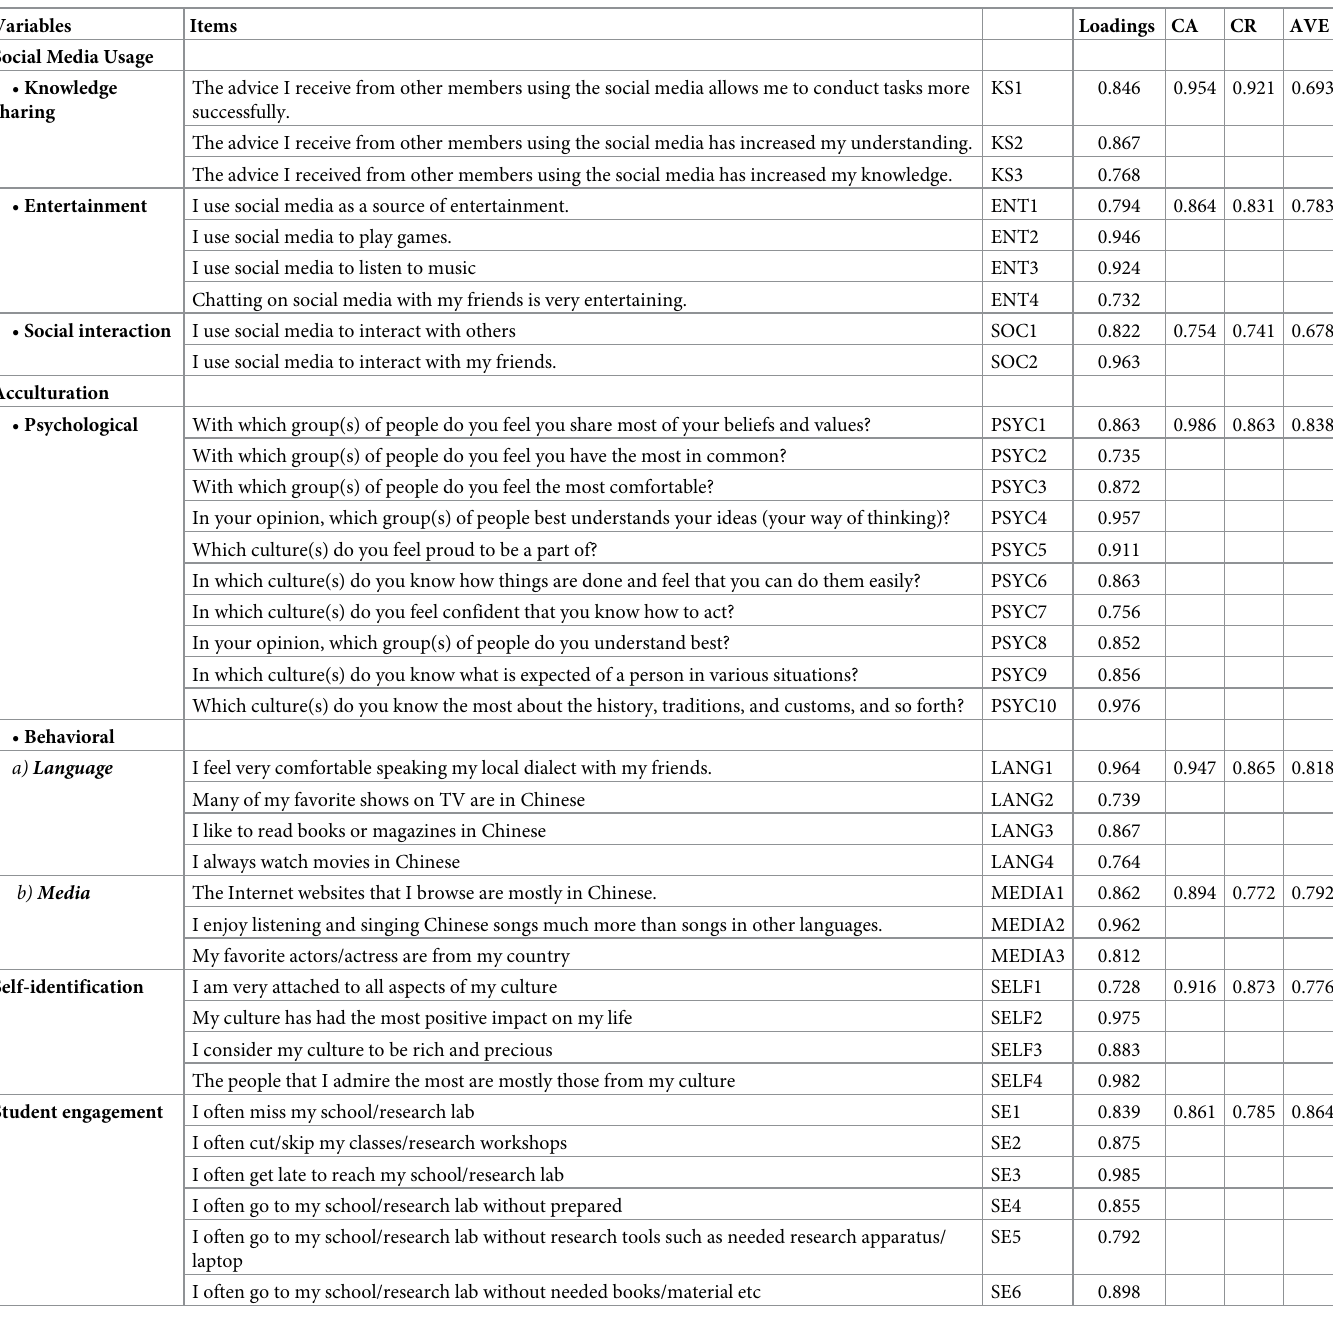
Table 3. Results of the items of construct, factor loadings and reliabilities. Variables